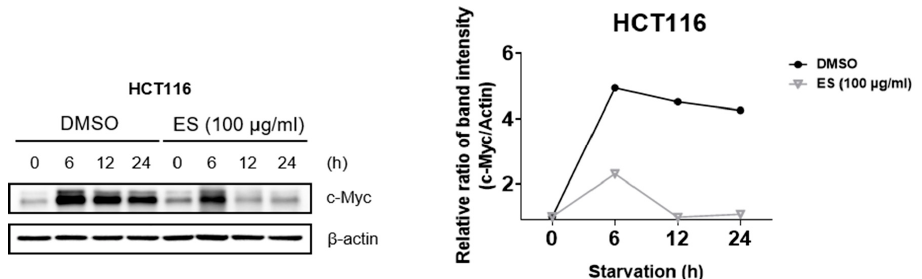
Figure 4. Effect of ES expression of serum-stimulated c-Myc in HCT116 cells. HCT116 cells treated with ES (100 µ g/mL) were starved in 0.2% FBS and were serum-stimulated (with 20% FBS).